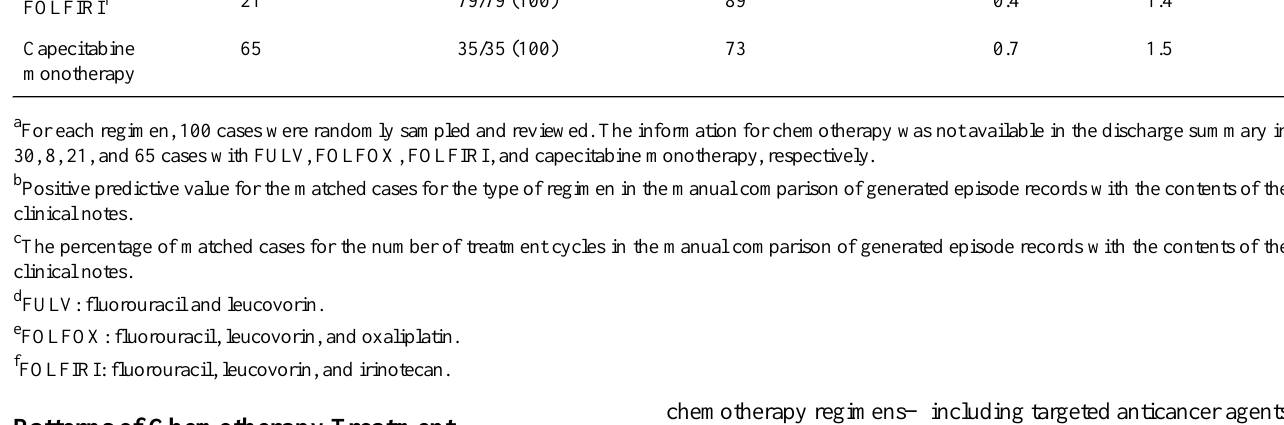
Patients by type of cancerCharacteristics of the patients